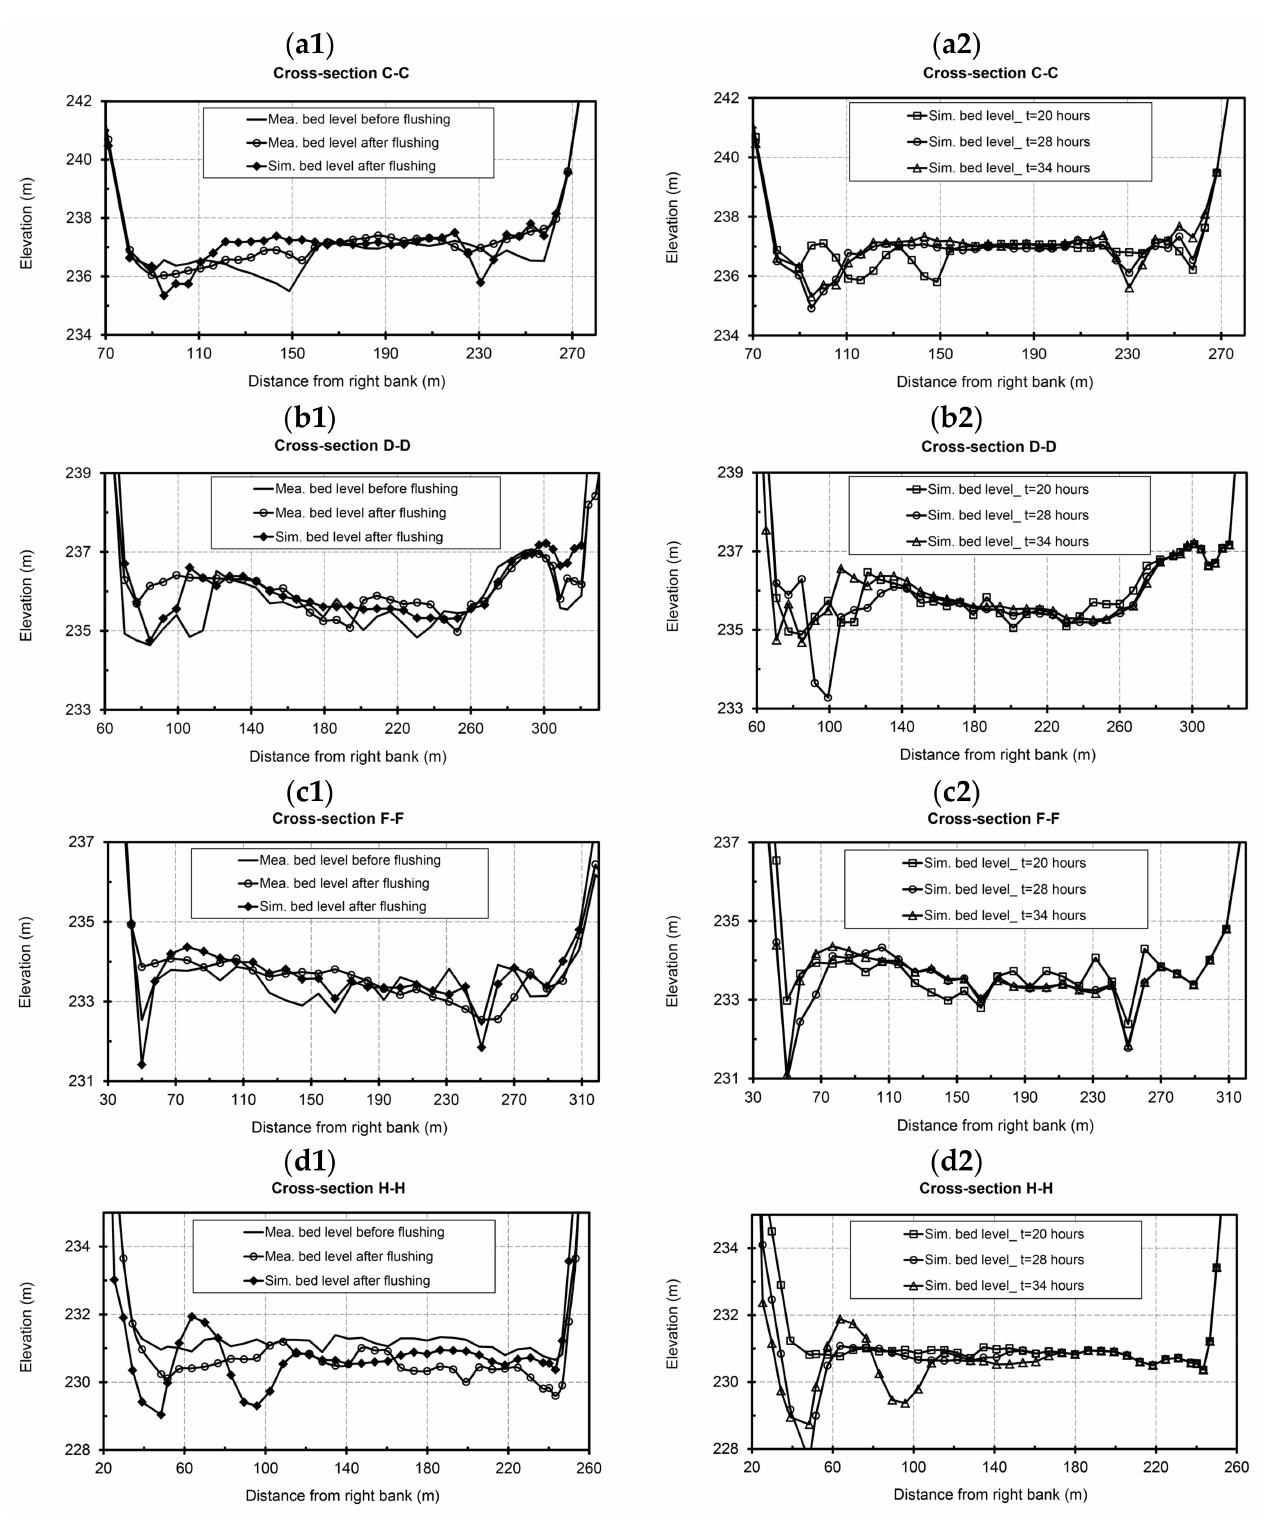
Figure 4. Bed variation measurements versus simulation results at ( a1 ) cross-section C–C; ( b1 ) cross-section D–D; ( c1 ) cross- section F–F; ( d1 ) cross-section H–H; ( a2 ), ( b2 ), ( c2 ) and ( d2 ) are corresponding simulated bed variations at the middle of drawdown (i.e., t = 20 h), beginning of free-flow (i.e., t = 28 h), and end of free-flow stage (i.e., t = 34